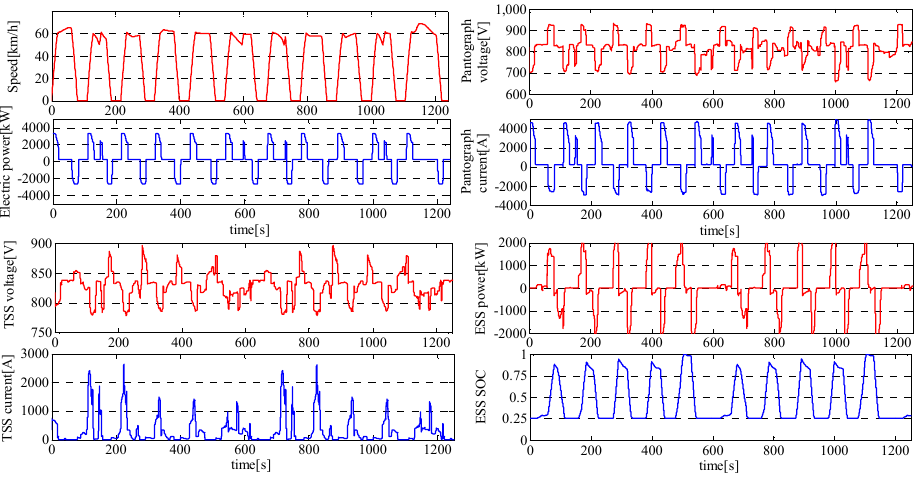
Figure 6. The output waveforms of simulation